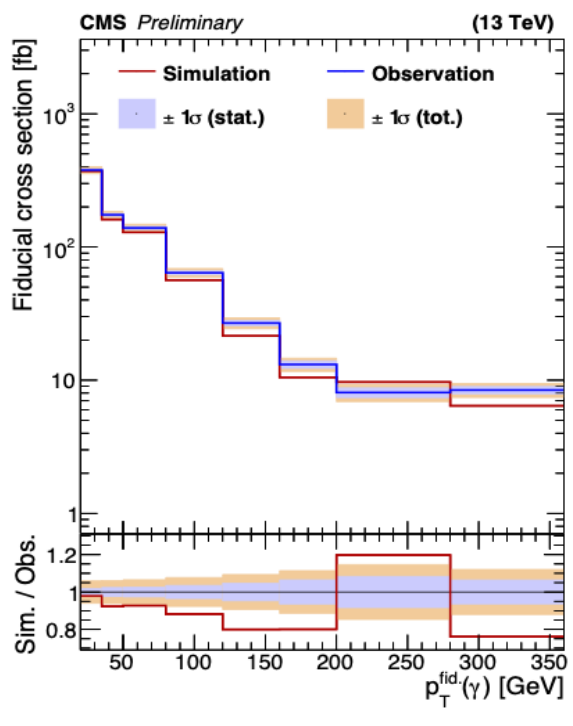
Figure 20. Differential t¯t γ production cross-section measurements by CMS in the single-lepton channel [47]. Results are also shown as a function of the transverse momentum of the photon at particle